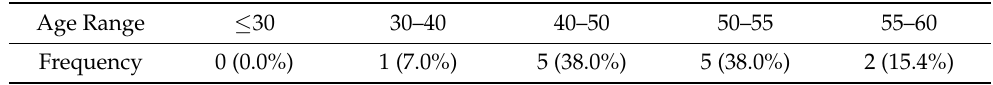
Table 2. Age of the teachers who participated in the workshop.